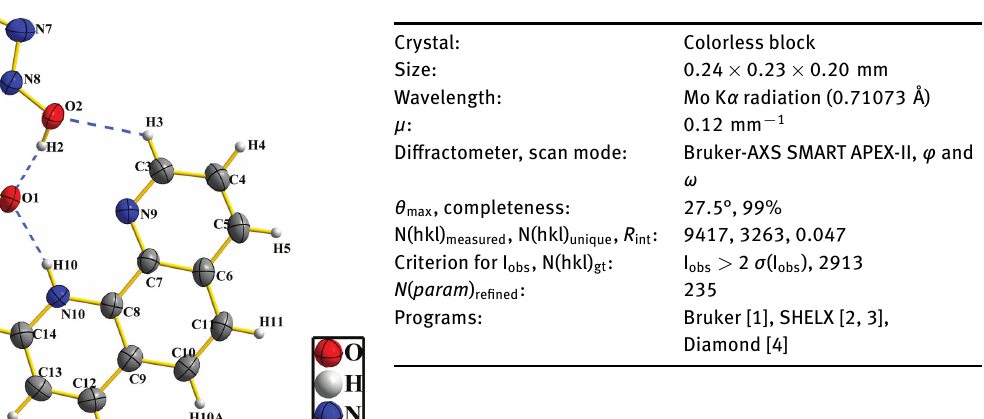
Table 1: Data collection and handling.